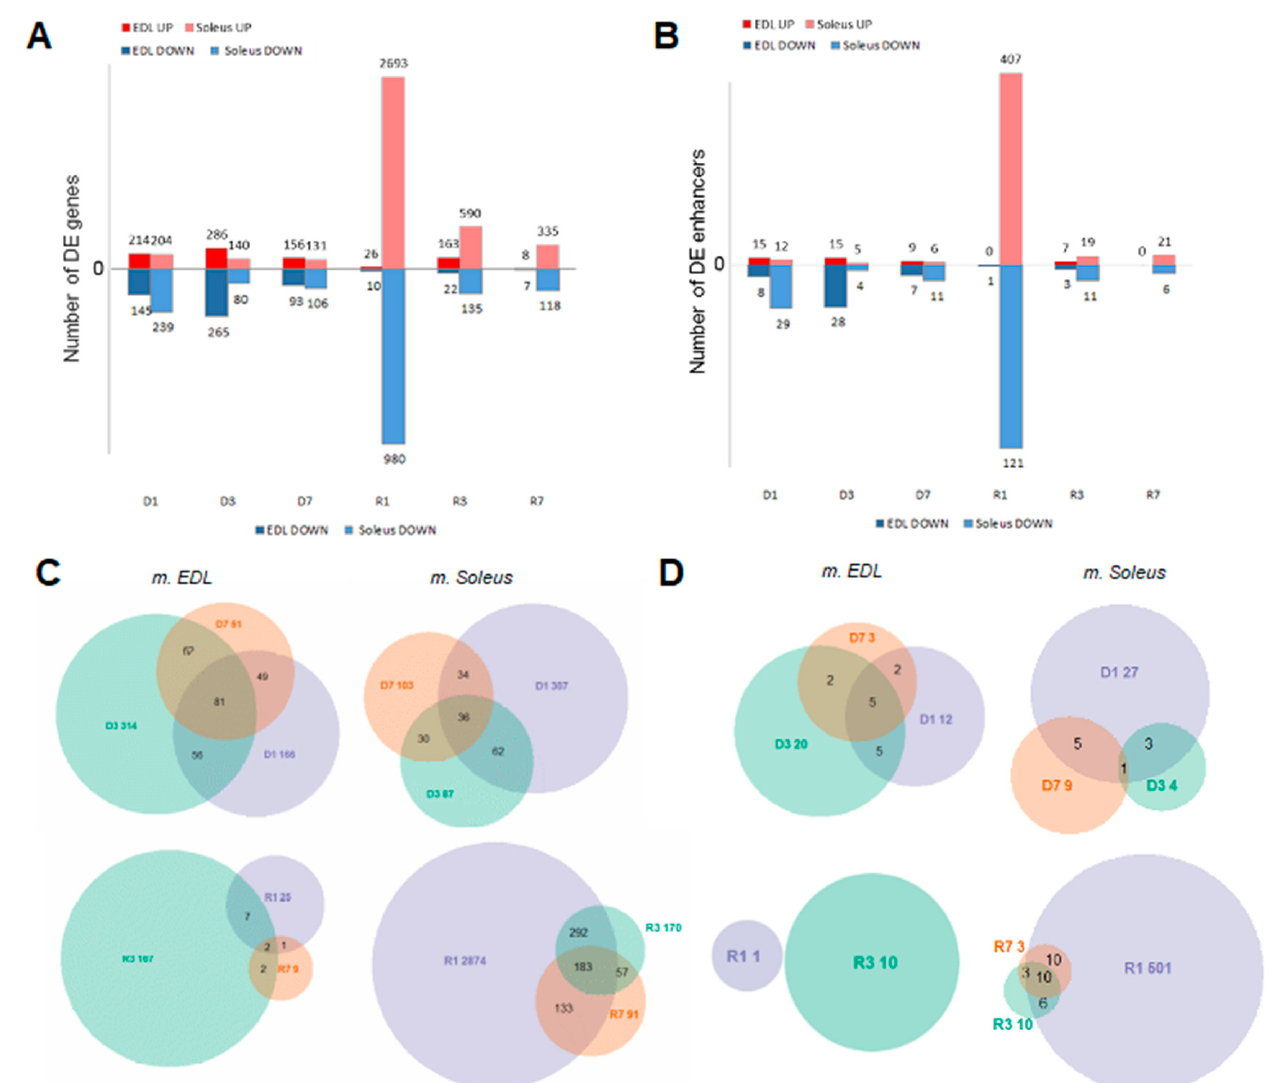
Figure 3. Differentially expressed genes (DEGs) and differentially expressed enhancers in soleus and EDL muscles. ( A ) Number of DEGs. ( B ) Number of differentially expressed enhancers. ( C ) DEGs in the fast and slow muscles (as compared to control) on days 1, 3 and 7 of disuse (shown as D1, D3, D7, respectively) and on days 1, 3, and 7 of recovery (shown as R1, R3, R7, respectively). ( D ) Differentially expressed enhancers in the fast and slow muscles (as compared to control) on days 1, 3 and 7 of disuse (shown as D1, D3, D7, respectively) and on days 1, 3, and 7 of recovery (shown as R1, R3, R7, respectively).